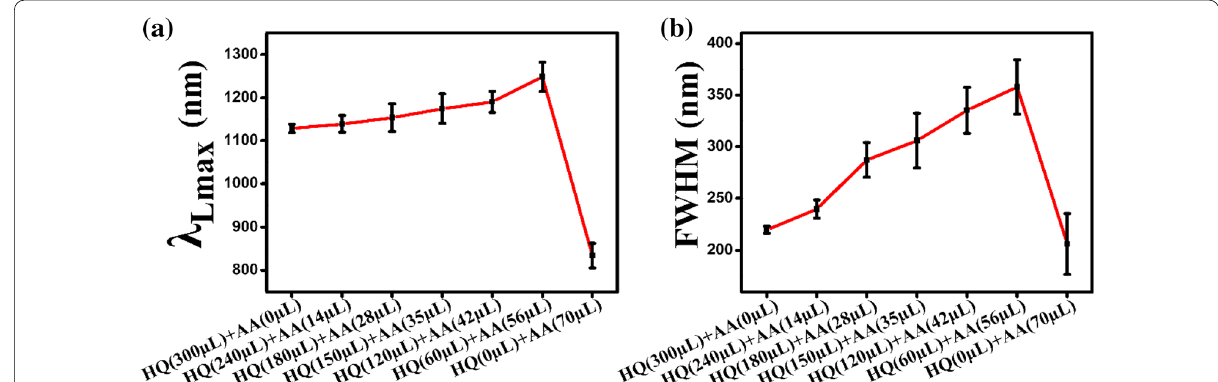
Fig. 4 TEM images of the Au NRs prepared by mixing different volumes of HQ and AA: a HQ(300 μL) HQ(180 μL) AA(28 μL), d HQ(150 μL) +